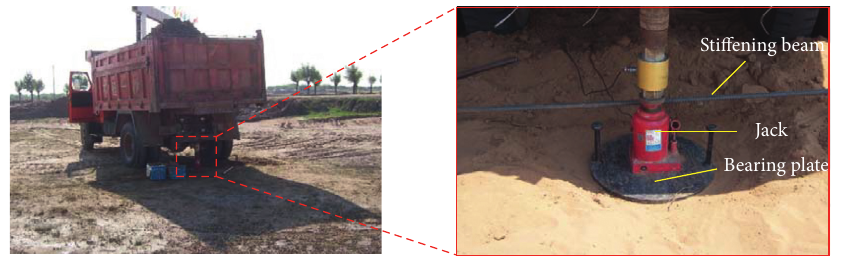
Figure 6: Test point and